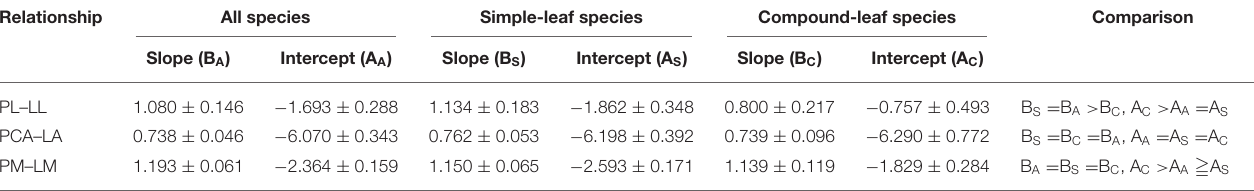
TABLE 3 | Summary of three dimensions of linear relationship (PL–LL, PCA–LA, and PM–LM) for all, simple-leaf and compound-leaf species group, respectively. Relationship All species Simple-leaf species Compound-leaf species Comparison